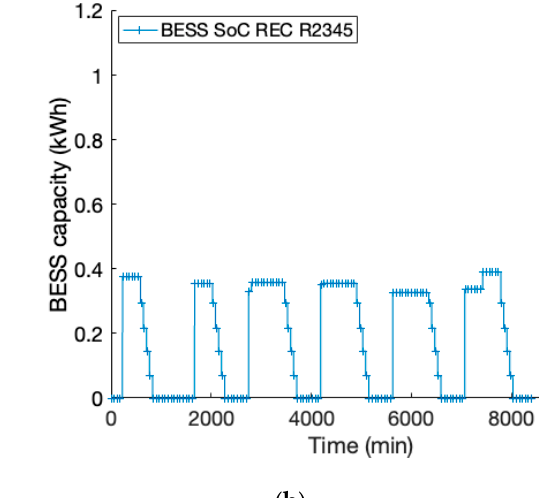
Figure 9. Extract of the BESS SoC curve (purple) over the same 6-days period for REC R1234 ( a ) and R2345 ( b ) configura- tions.